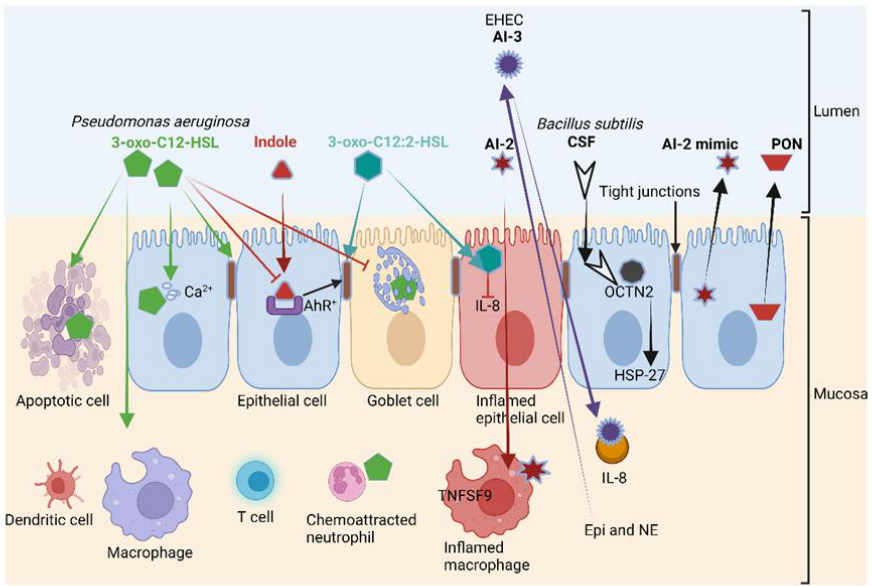
Figure 5. The 3-oxo-C12-HSL produced by P. aeruginosa (also shown in Figure 1) induces apoptosis in various cell types, including epithelial cells; disrupts tight junctions and decreases mucin production. Intestinal acyl-homoserine lactone (3-oxo-C12:2-HSL) and indole (produced from tryptophan) protect tight junctions. The competence and sporulation factor (CSF), a pentapeptide produced by B. subtilis , binds to the cation transporter OCTN2 and activates heat shock protein 27 (HSP-27), which increases the strength of intestinal barriers. Meanwhile, 3-oxo-C12-HSL stimulates chemoattraction and phagocytosis in neutrophils and induces cell death. The autoinducers AI-2 and AI-3 induce the expression of the immune mediators TNSF9 and interleukin (IL)-8, respectively, leading to the inflammation of macrophages, while 3-oxo-C12:2-HSL reduces IL-8 production. Epinephrine (Epi) and norepinephrine (NE) bind to the AI-3 receptor in enterohemorrhagic E. coli (EHEC), thereby interfering with QS. Intestinal epithelial cells secrete a mimic form of AI-2 and paraoxonase (PON) to degrade HSLs. AhR: Aryl hydrocarbon receptor. This illustration was constructed using BioRender (https://biorender.com/, assessed on 6 September 2022).